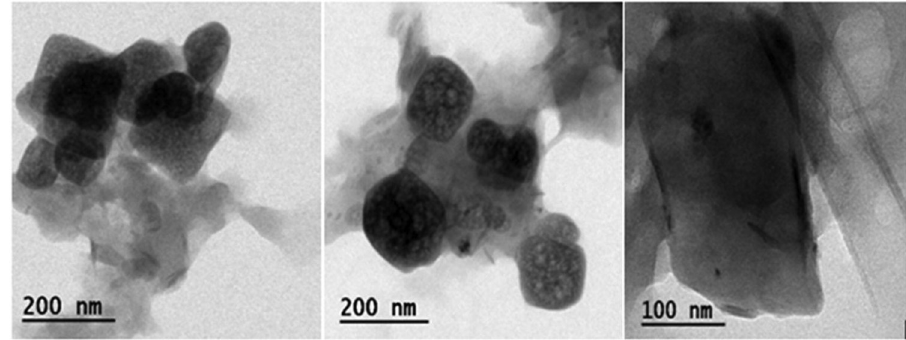
Figure 5: High - resolution transmission electron microscope of synthesized AS - ZnONPs.